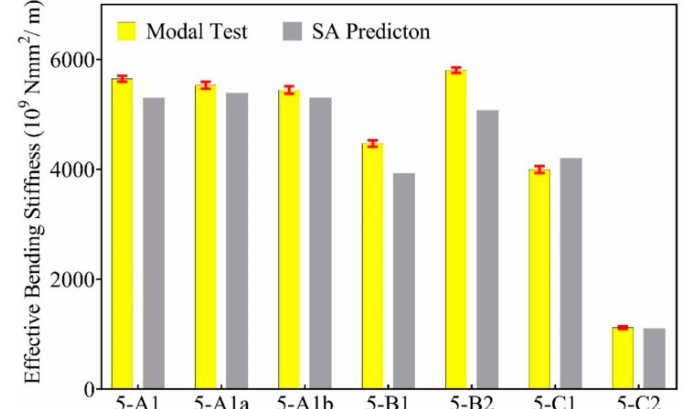
Figure 11. Effective bending stiffness of 5-layer MTPs by modal test and shear analogy method.